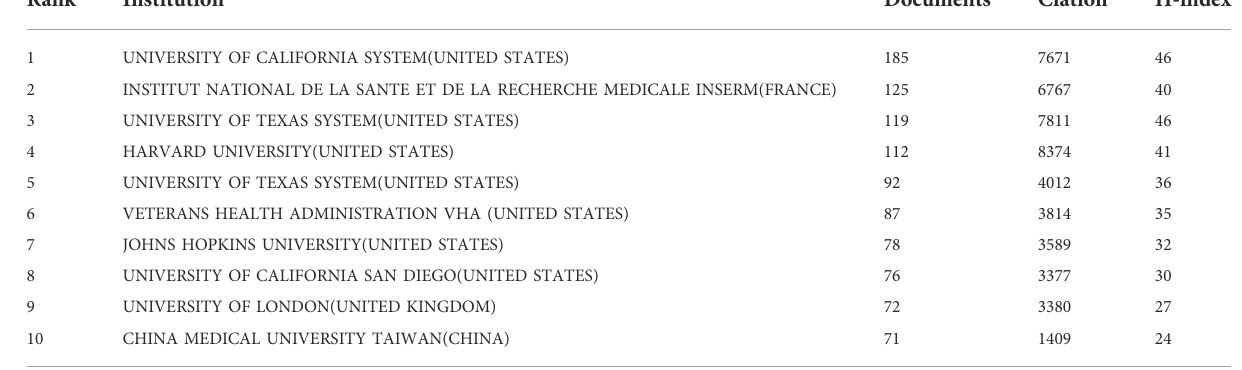
TABLE 2 Top 10 the most productive institutions.